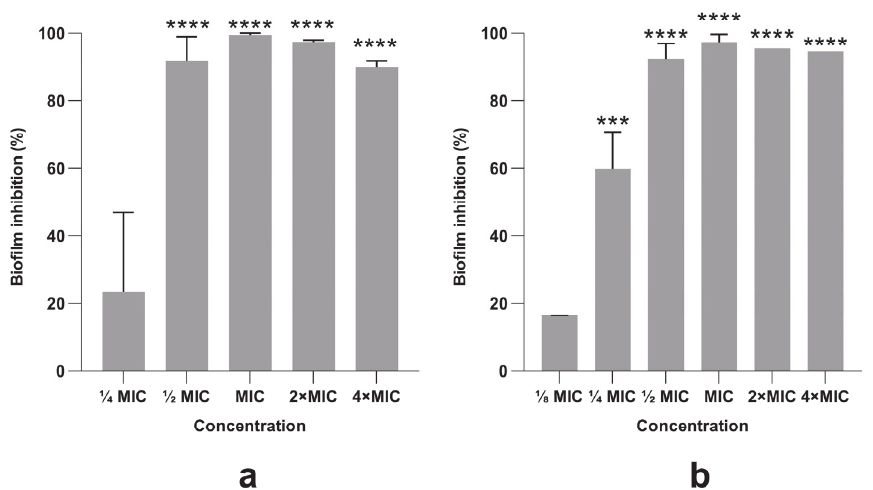
Figure 6. Anti-biofilm activity of ( a ) PlLm and ( b ) PlLe extracts at different concentrations. Values are the means of at least three replicates. Bars indicate standard deviations. Asterisks represent a significant difference ( p < 0.05) vs. control (*** = p = 0.0001; **** = p < 0.0001).